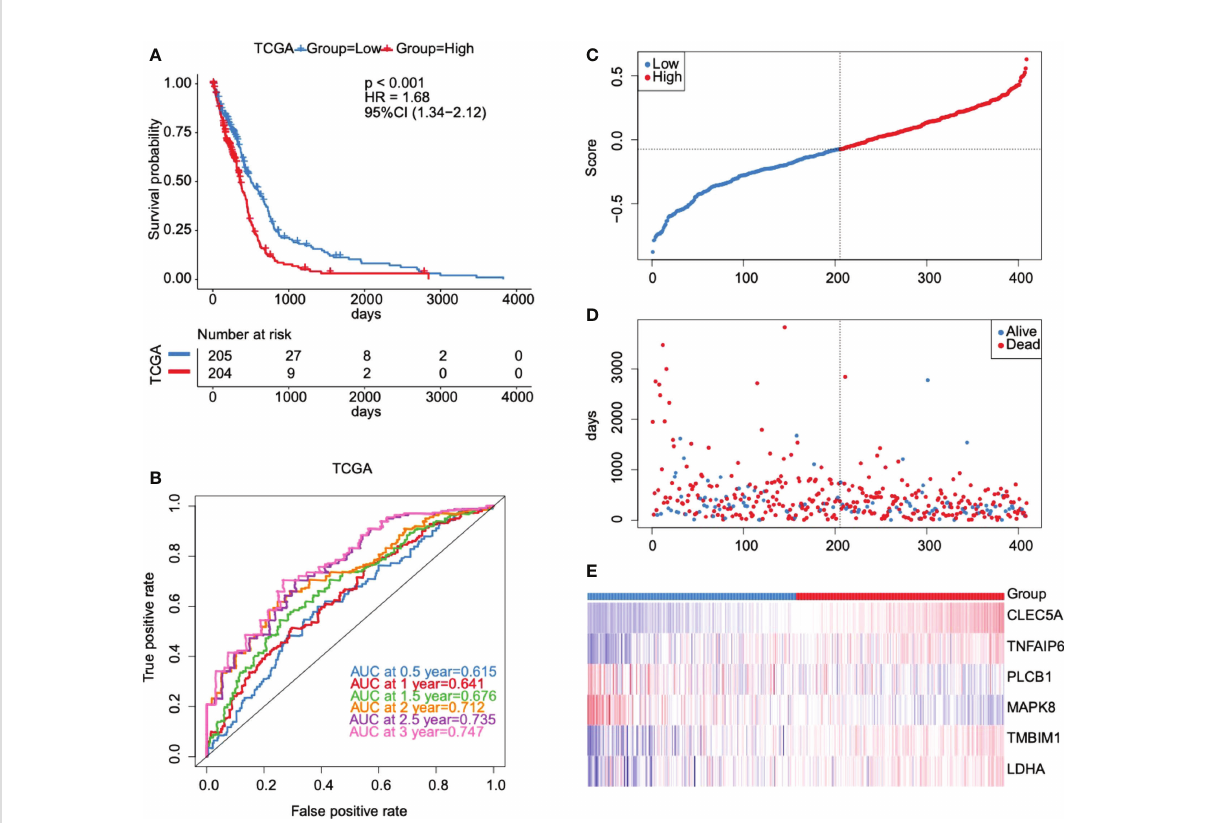
FIGURE 6 Evaluation and validation of the prognostic model in the TCGA database. (A) Kaplan-Meier survival curves for high- and low-risk groups strati fi ed by the risk score model in the TCGA database. (B) ROC curves for predicting 0.5-year, 1-year, 1.5-year, 2-year, 2.5-year, and 3-year OS for GBM patients based on the risk score in the TCGA database. (C – E) Risk score distribution, GBM patients ’ survival status, and six key prognostic glycolytic core genes expression heat map in the TCGA